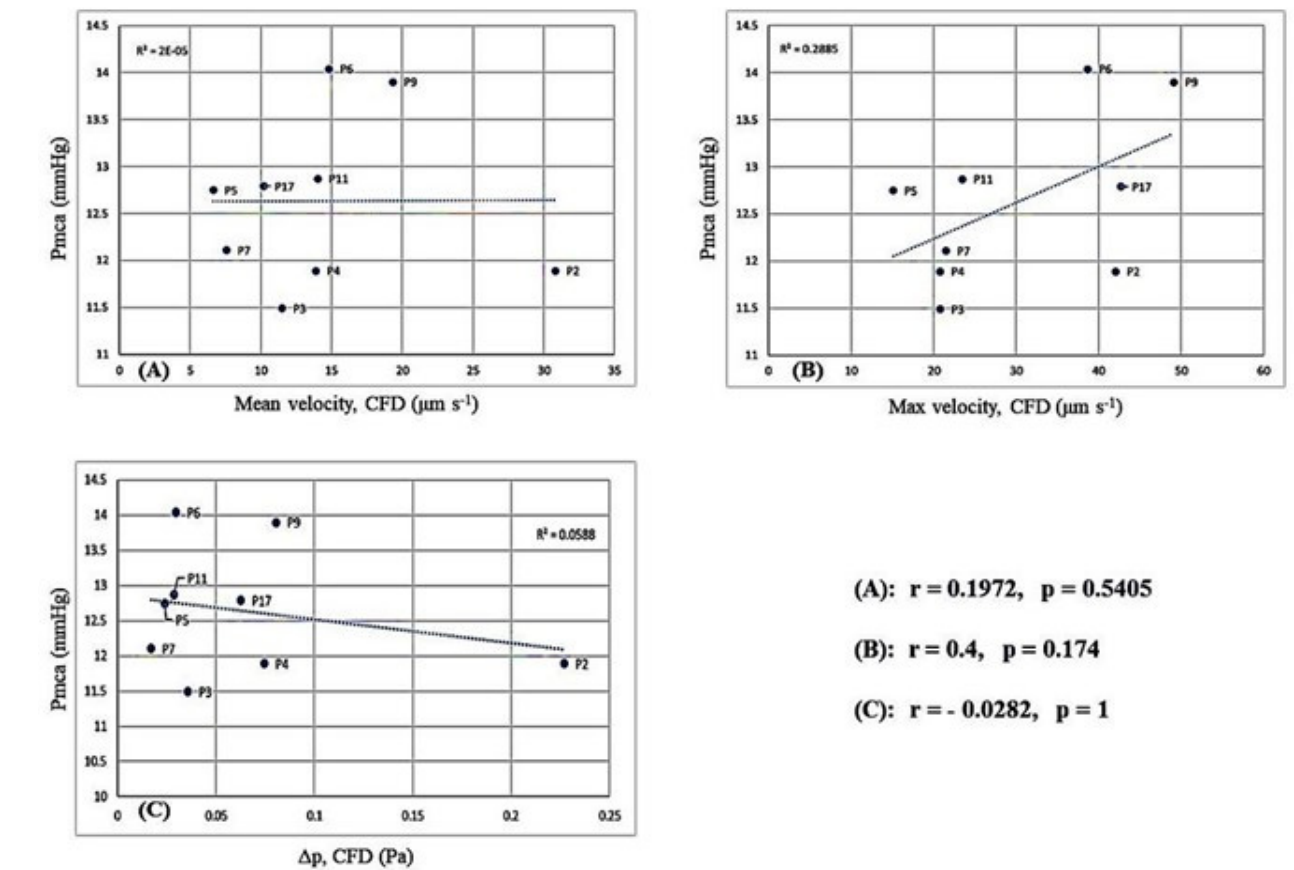
Figure 4. Computational fluid dynamics simulation: ( A ) correlation between Pmca and mean RBC velocity; ( B ) correlation between Pmca and maximum RBC velocity in the domain; and ( C ) correlation between Pmca and pressure difference ( Δ p).